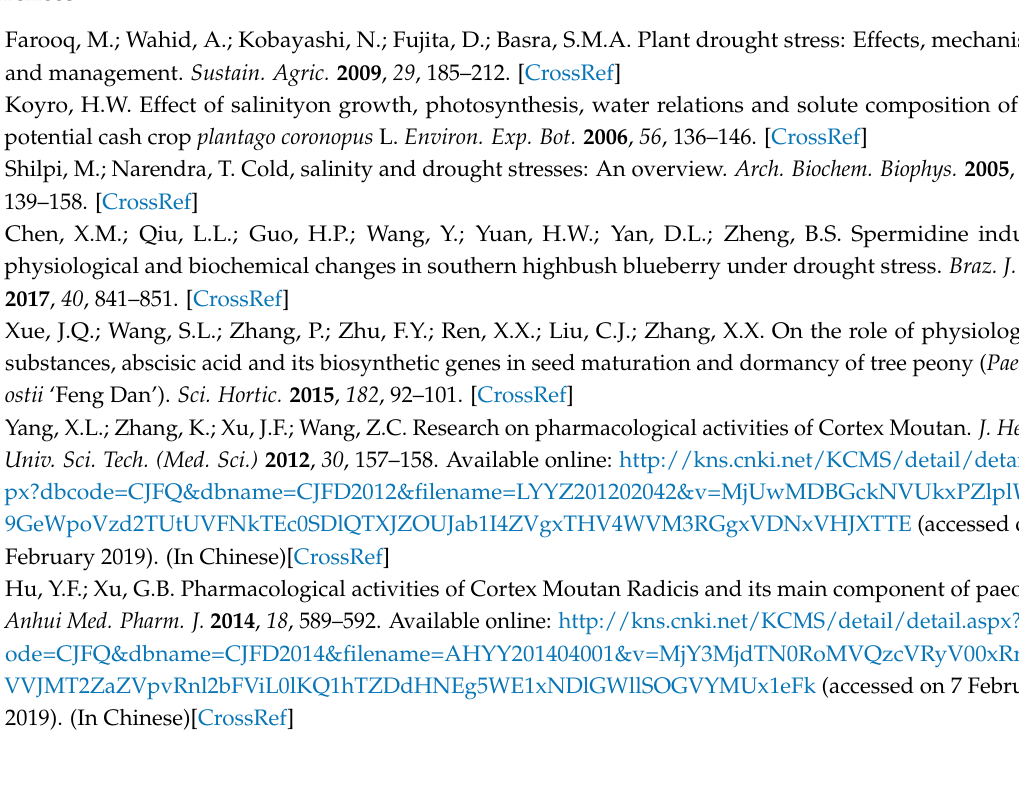
Table S1. Primers used for qRT-PCR, Table S2. Output statistics of RNA-Seq of drought-treated P. ostii and the control, Table S3. Six categories pathways and DGEs, Figure S1. Functional annotation of P. ostia unigenes from